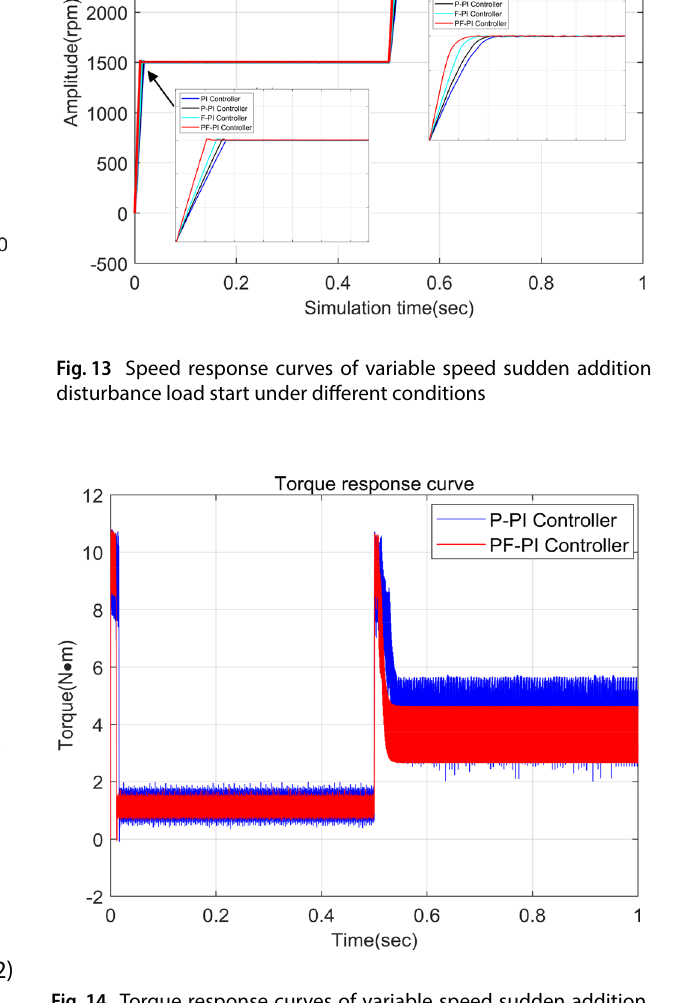
Table 6 The speed performance of different schemes